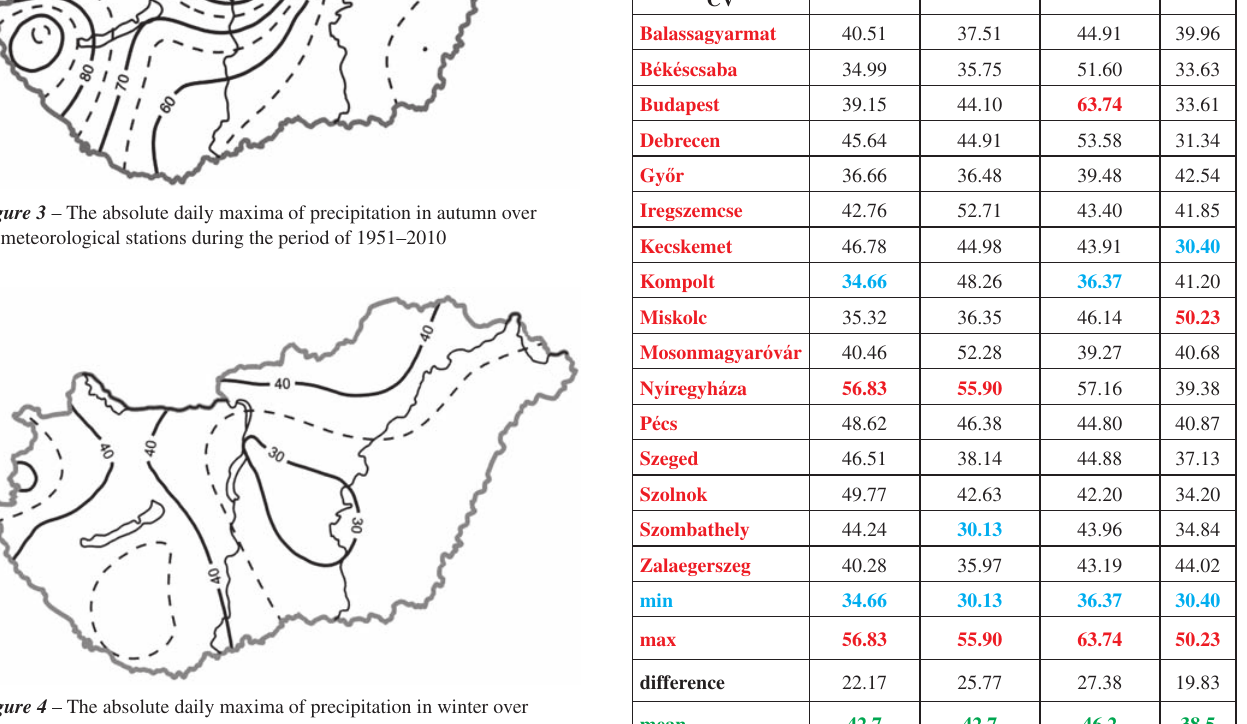
Table 1 – Coeffi cients of variation of absolute daily maxima of precipitation raised at 16 stations in seasonal distribution over 1951–2010 ABS. MAX. PREC.